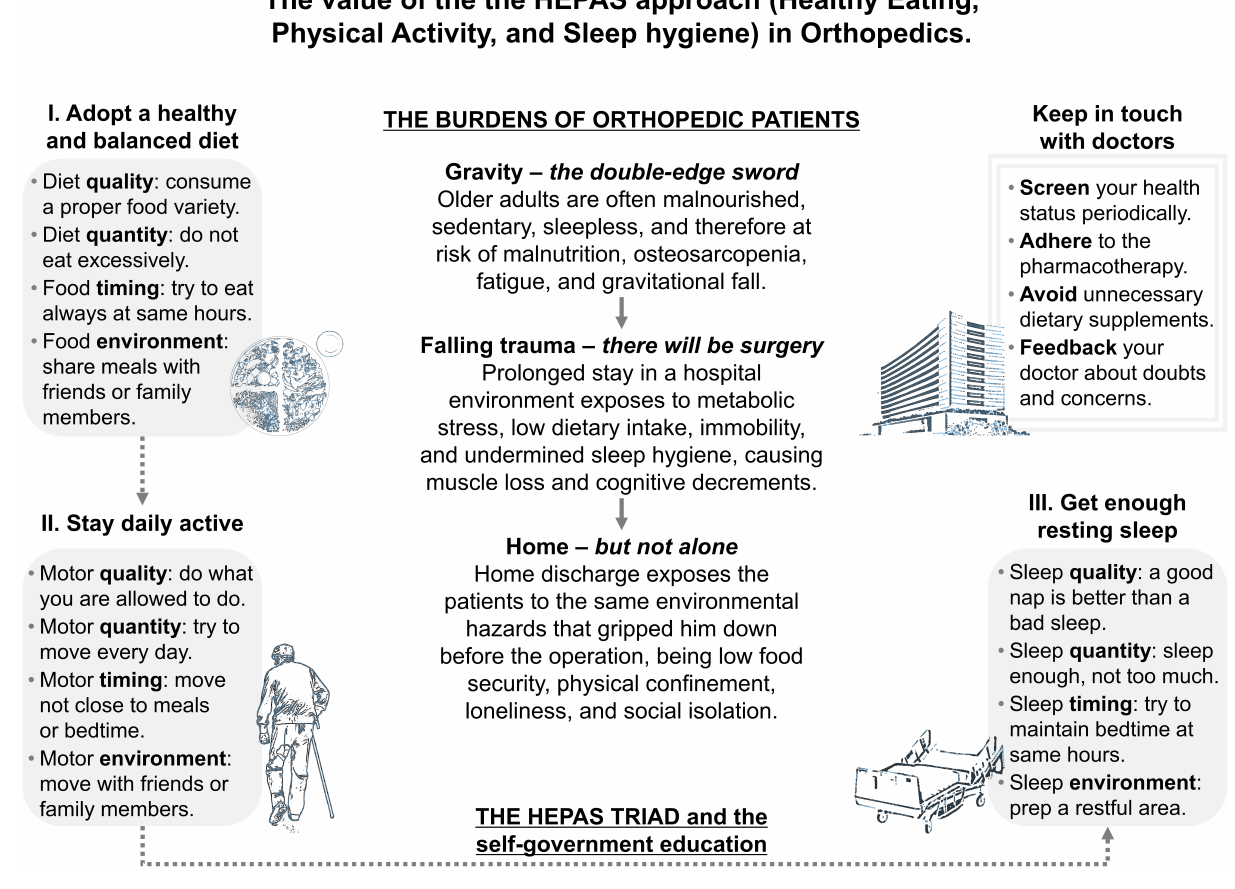
FIGURE 1 | The value of the HEPAS approach (Healthy Eating, Physical Activity, and Sleep hygiene) in Orthopedics. Each phase of musculoskeletal disease progression and care path is known to be stumbling upon deficits of nutritional, motor, and night-rest nature, eventually leading to falling traumas or orthopedic surgery. The HEPAS approach brings together indications on healthy eating, physical activity, and sleep hygiene. This triad, completed by an appropriate self-government education, may be the ideal candidate program to support individual health both in the home environment and institutionalized